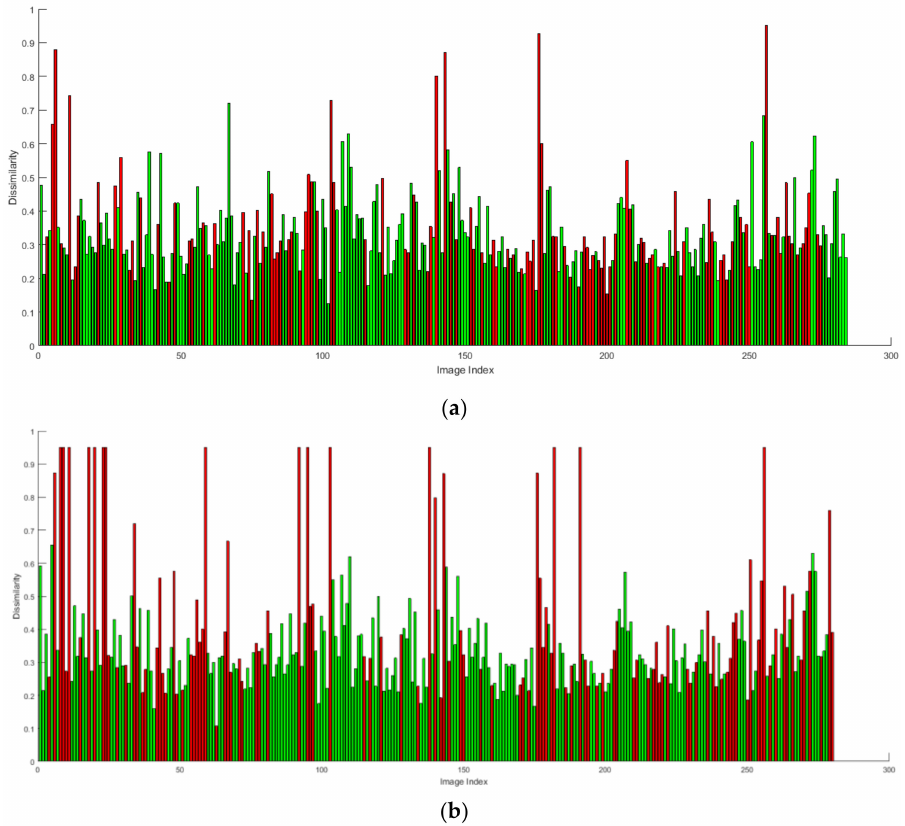
Figure 14. Results obtained by matching the images using ( a ) SIFT and ( b ) SURF descriptors. Green bars represent true matches while red bars represent false matches (discharged